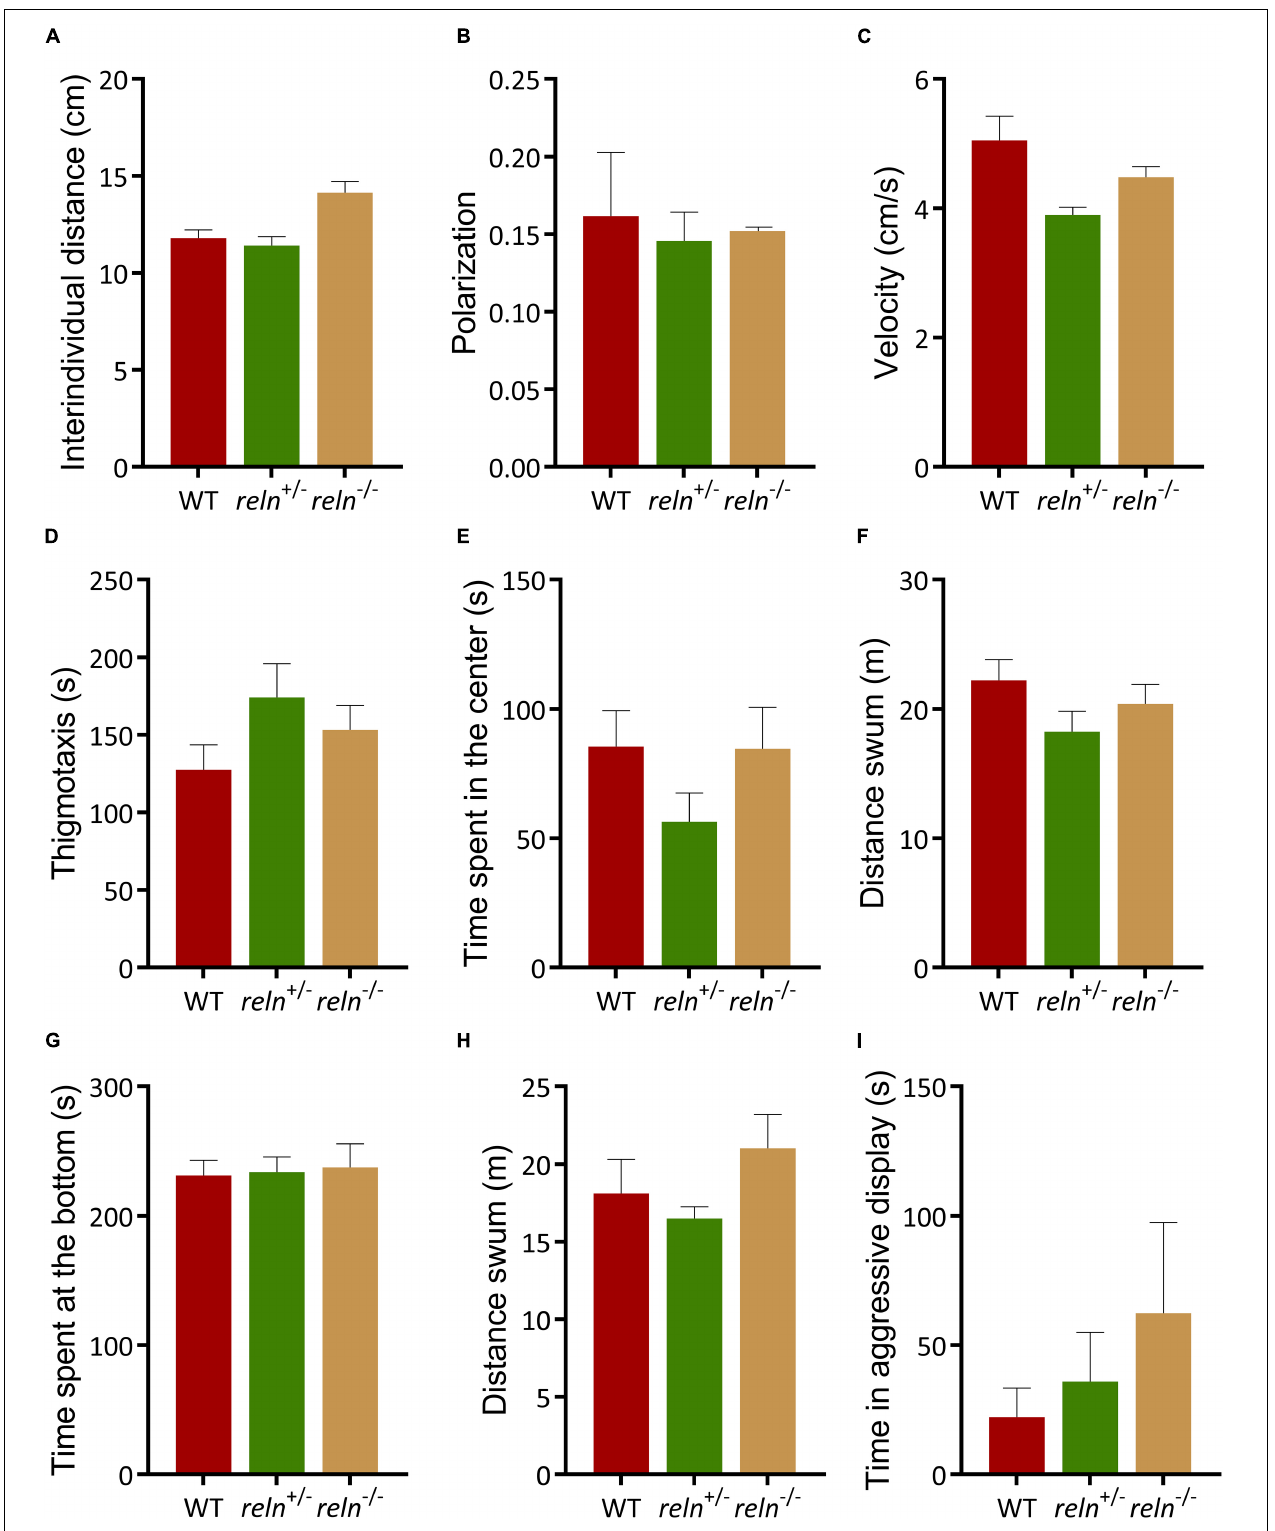
FIGURE 3 | Behavior of reln + / − and reln − / − zebrafish. (A–C) Both genotypes shoal normally. (A) Inter-individual distance (Kruskal–Wallis test with Dunn’s multiple comparisons test: chi-square = 3.71, p > 0.99 for reln + / − and p = 0.36 for reln − / − ); (B) Polarization (Kruskal–Wallis test with Dunn’s multiple